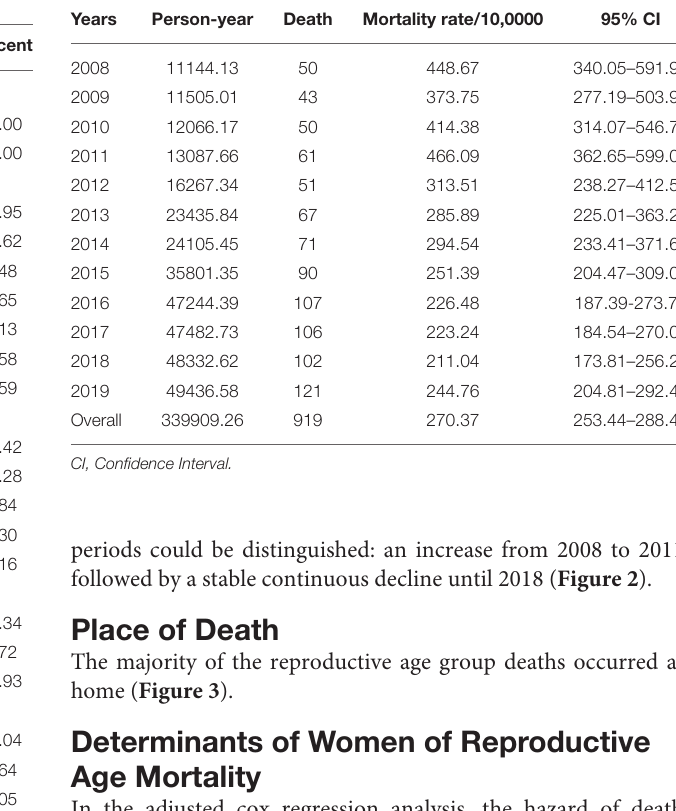
TABLE 2 | Women reproductive age mortality in Kersa HDSS, Eastern Ethiopia from 2008 to